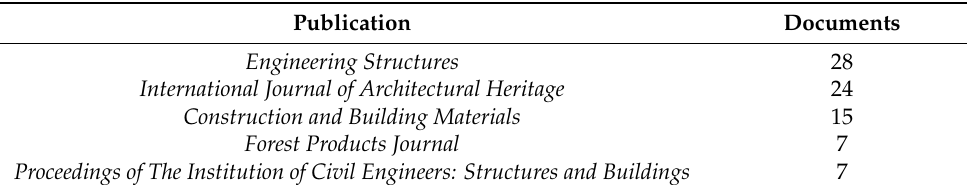
Figure 6. Number of published articles since 1999. Table 1. Journals with the most relevant articles.